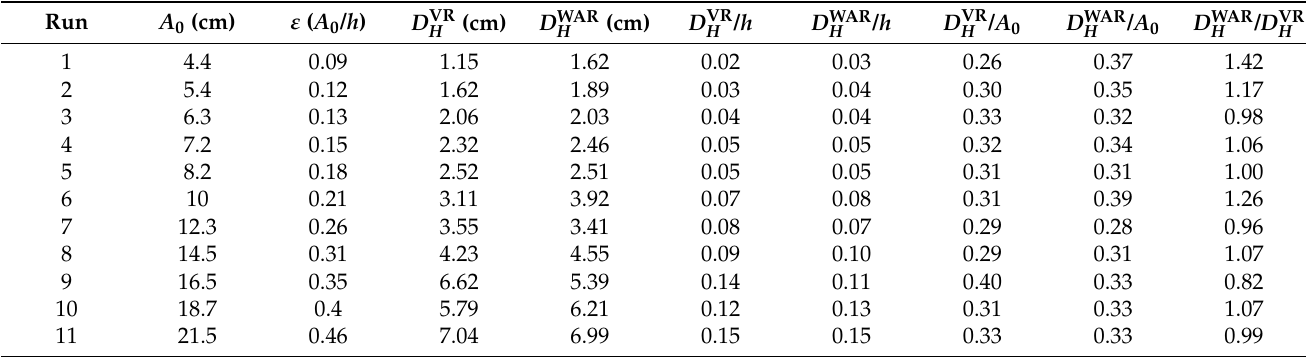
Table A4. Maximum inundation heights at WG5 ( x / h =